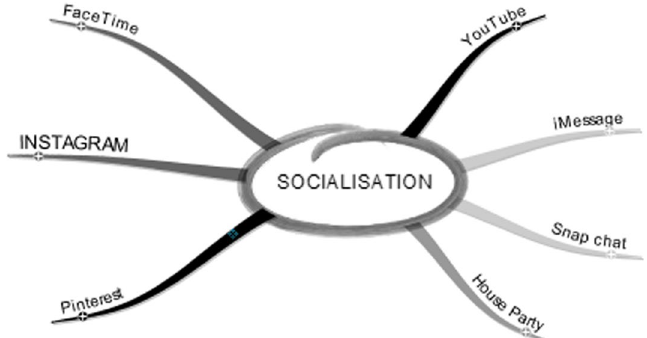
Fig. 4 The tools students use for social interaction